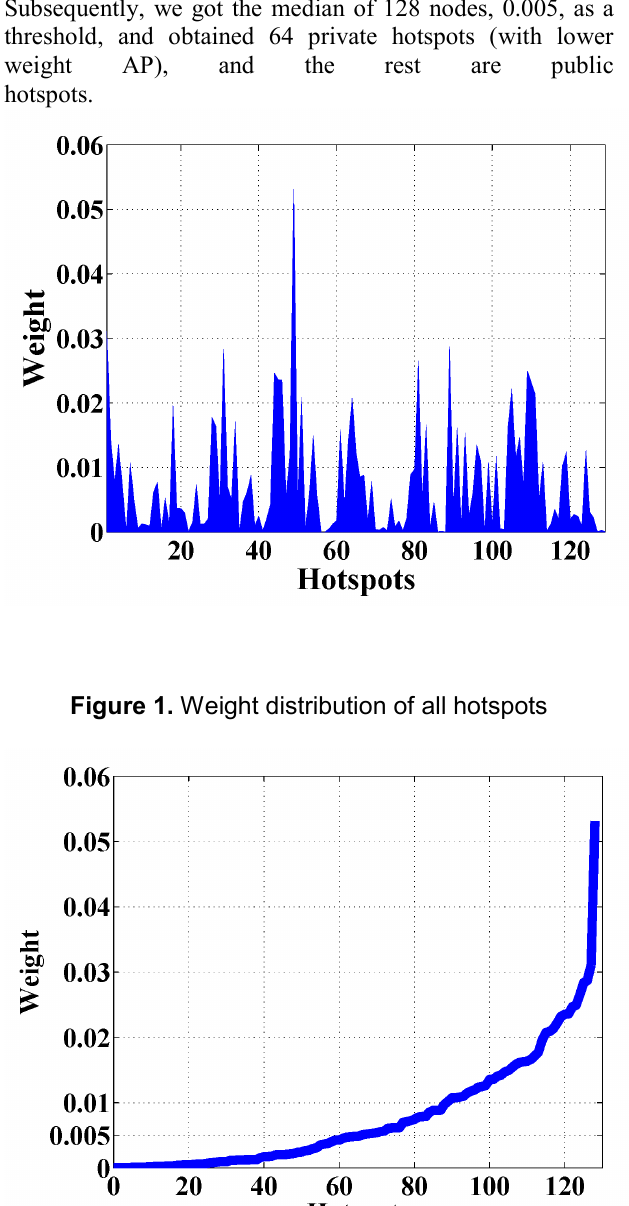
Figure 2. Weights number distribution of the